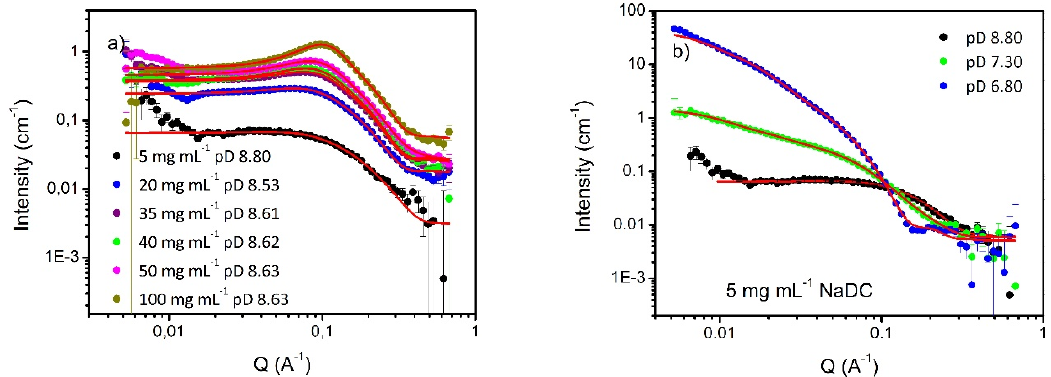
Figure 2. Small angle-neutron scattering data of NaDC as a function of: panel ( a ) concentration, at pD 8.5–8.8 and panel ( b ) pD, at 5 mg mL − 1 concentration. Fittings are reported in the graph as red lines.